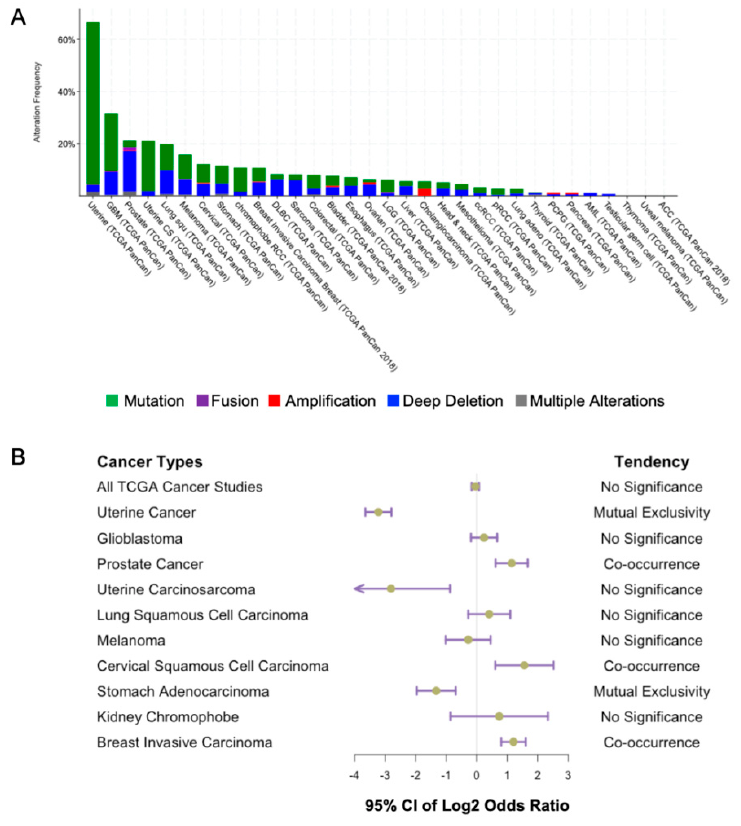
Figure 5. Alteration frequency of PTEN in human cancers. ( A ) Alteration frequency (%) of PTEN in indicated tumor types. ( B ) The extent of co-occurrence of PTEN and TP53 mutations in different human tumors are shown. Data obtained from cBioPortal for Cancer Genomics database (https://www.cbioportal.org).